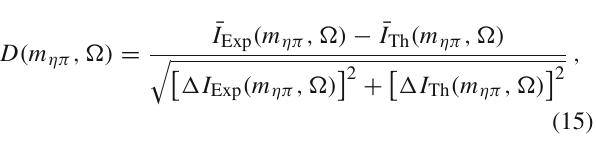
In Appendices C and D we compare MVR and